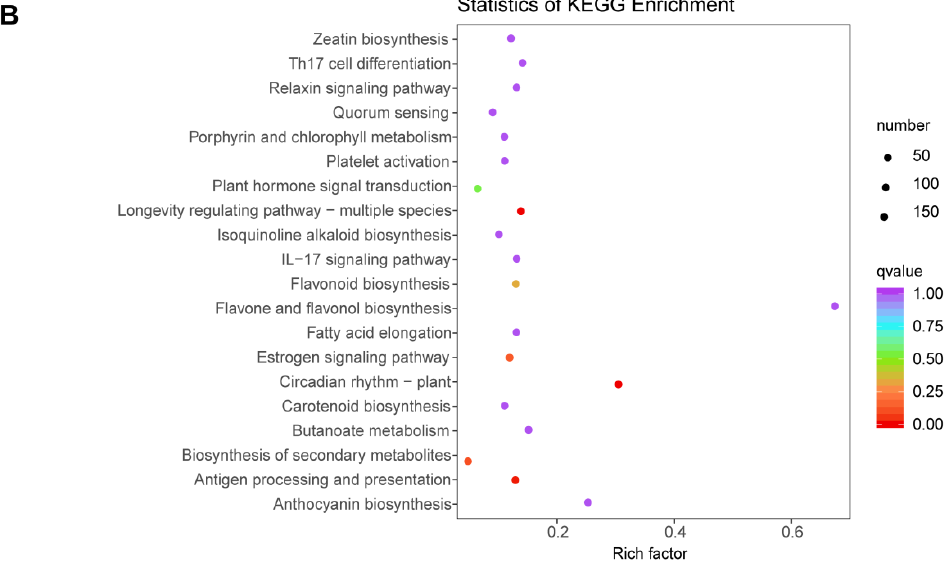
Figure 3. Bioinformatic analysis on differentially expressed genes induced by low light treatments in the petiole of XH1 cai-tai seedlings. ( A ) Top 50 terms based on Gene Ontologies (GO) enrichment analysis. ( B ) Top 20 terms based on Kyoto Encyclopedia of Genes and Genomes (KEGG) analysis.